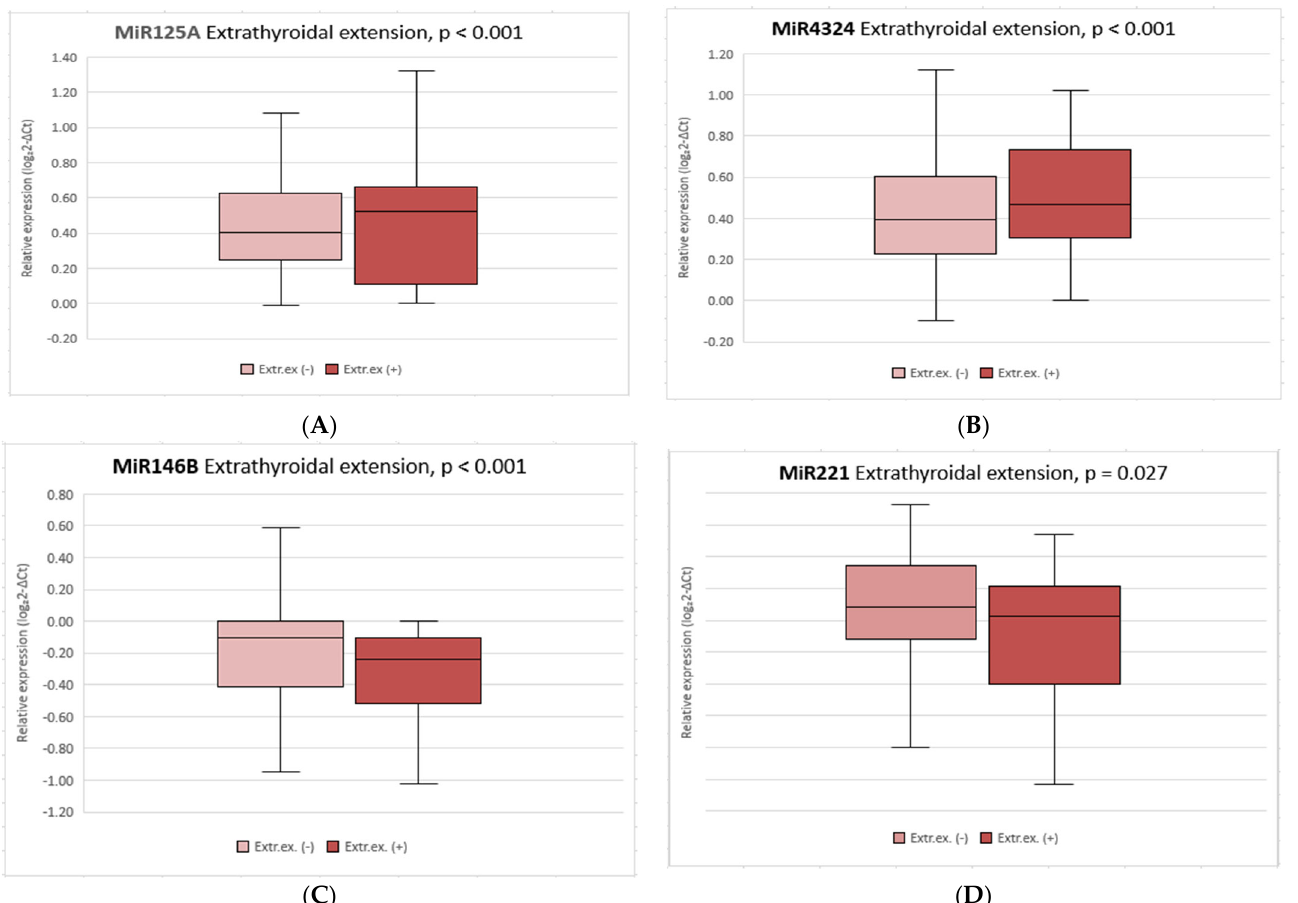
Figure 2. Comparison of miRNAs’ relative expression between PTC with and without extrathyroidal extension; miR125A ( A ); miR4324 ( B ); miR146B ( C ); miR221 ( D ). The box squares represent the data within 25 and 75 percentiles, the line in the middle shows the median; p < 0.05.